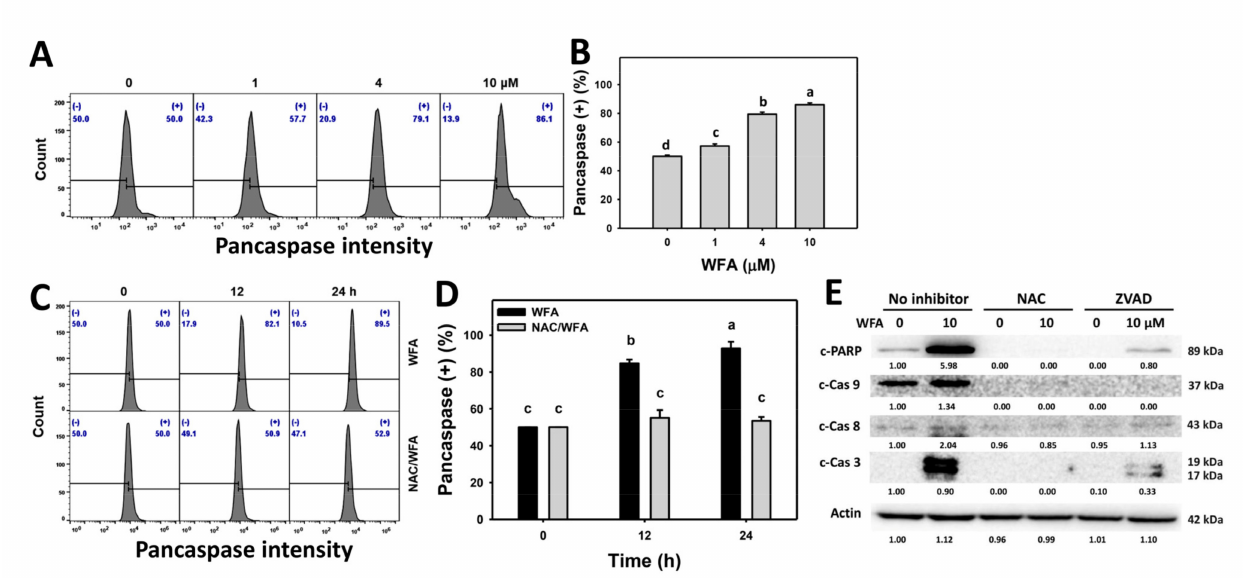
Figure 4. WFA activates caspases in bladder cancer cells. ( A , B ) Patterns and statistics for pancaspase change. Bladder cancer cells (J82) were treated with WFA (24 h, 0 to 10 µ M), where the negative control for WFA (0 µ M) contained 0.1% DMSO. Symbol (+) indicates pancaspase (+). ( C , D ) Pattern and statistics for the NAC pretreated effect on pancaspase change of J82 cells following WFA incubation. Cells were pretreated and post treated with NAC (8 mM, 1 h) and WFA (0 and 10 µ M for 12 and 24 h), respectively. Data, mean ± SD ( n = 3). Columns showing non-overlapping lower-case letters indicate p < 0.05 for multiple comparisons. ( E ) Western blotting analysis for NAC or ZVAD pretreated effects on apoptosis signaling expression of J82 cells following WFA incubation. Cells were pretreated and post treated with NAC (8 mM, 1 h) or apoptosis inhibitor Z-VAD-FMK (ZVAD) (20 µ M, 2 h) and WFA (0 and 10 µ M for 24 h), respectively, where the negative control for WFA (0 µ M) contained 0.1%